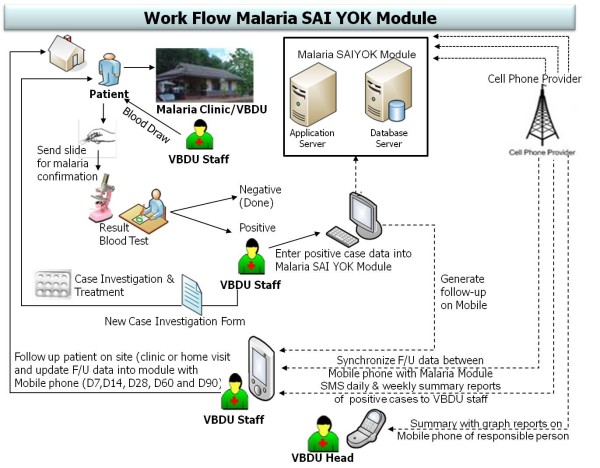
Conceptual framework and work flow of DTMM.